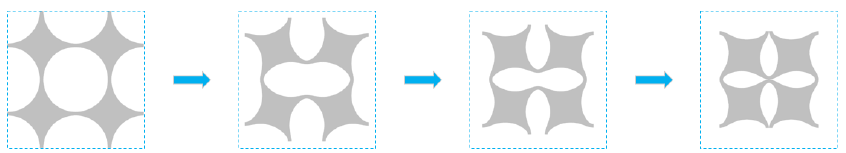
Figure 3. Mechanical behaviour during compression of periodic pattern S 0 . Configurations for different values of deformation (Respectively from left to right: 0%, 10%, 20%, ≈ 30%).